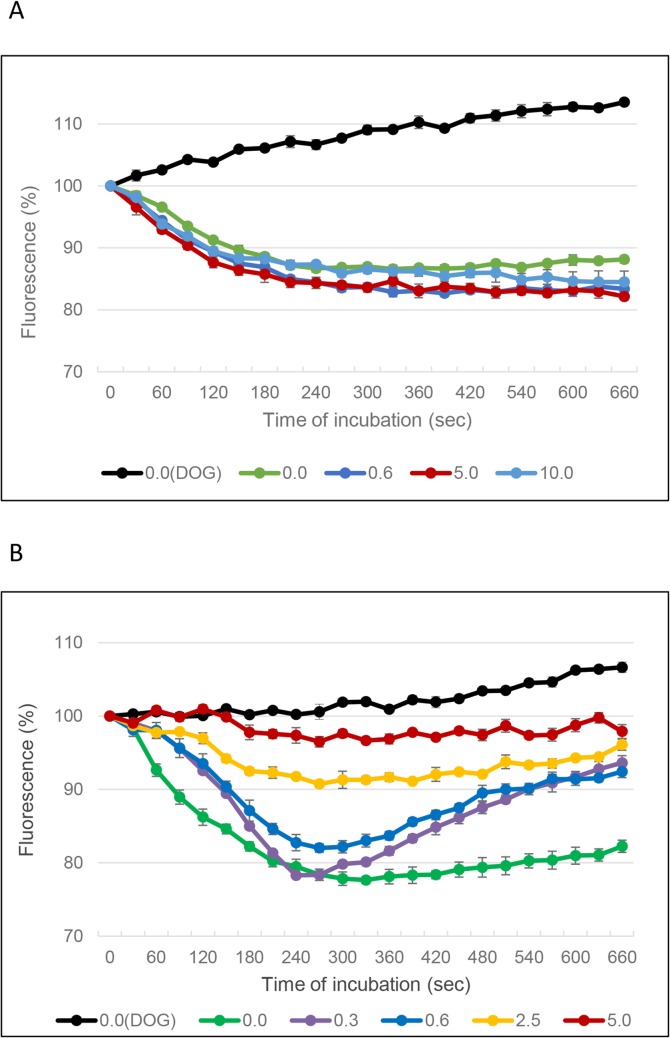
Effect of compound A on Nile Red efflux from S. cerevisiae cells expressing CaCdr1p or CaMdr1p membrane transporters.A: AD/CaCDR1; B: AD/CaMDR1. Efflux of Nile Red was initiated by adding glucose (50 μl 80 mM) at time 0 (except for black line which represents cells to which DOG was added rather than glucose, and no compound A was added). Cell-associated Nile Red fluorescence was measured. Legend: concentration of compound A in μM. Data are representative of 3 separate experiments.